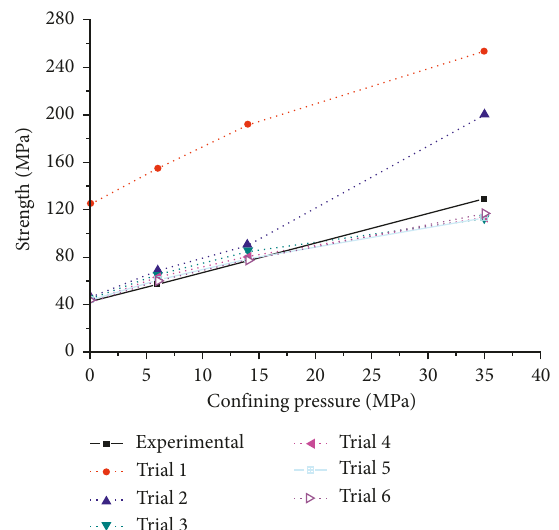
Figure 9: Calibration process of interlayered